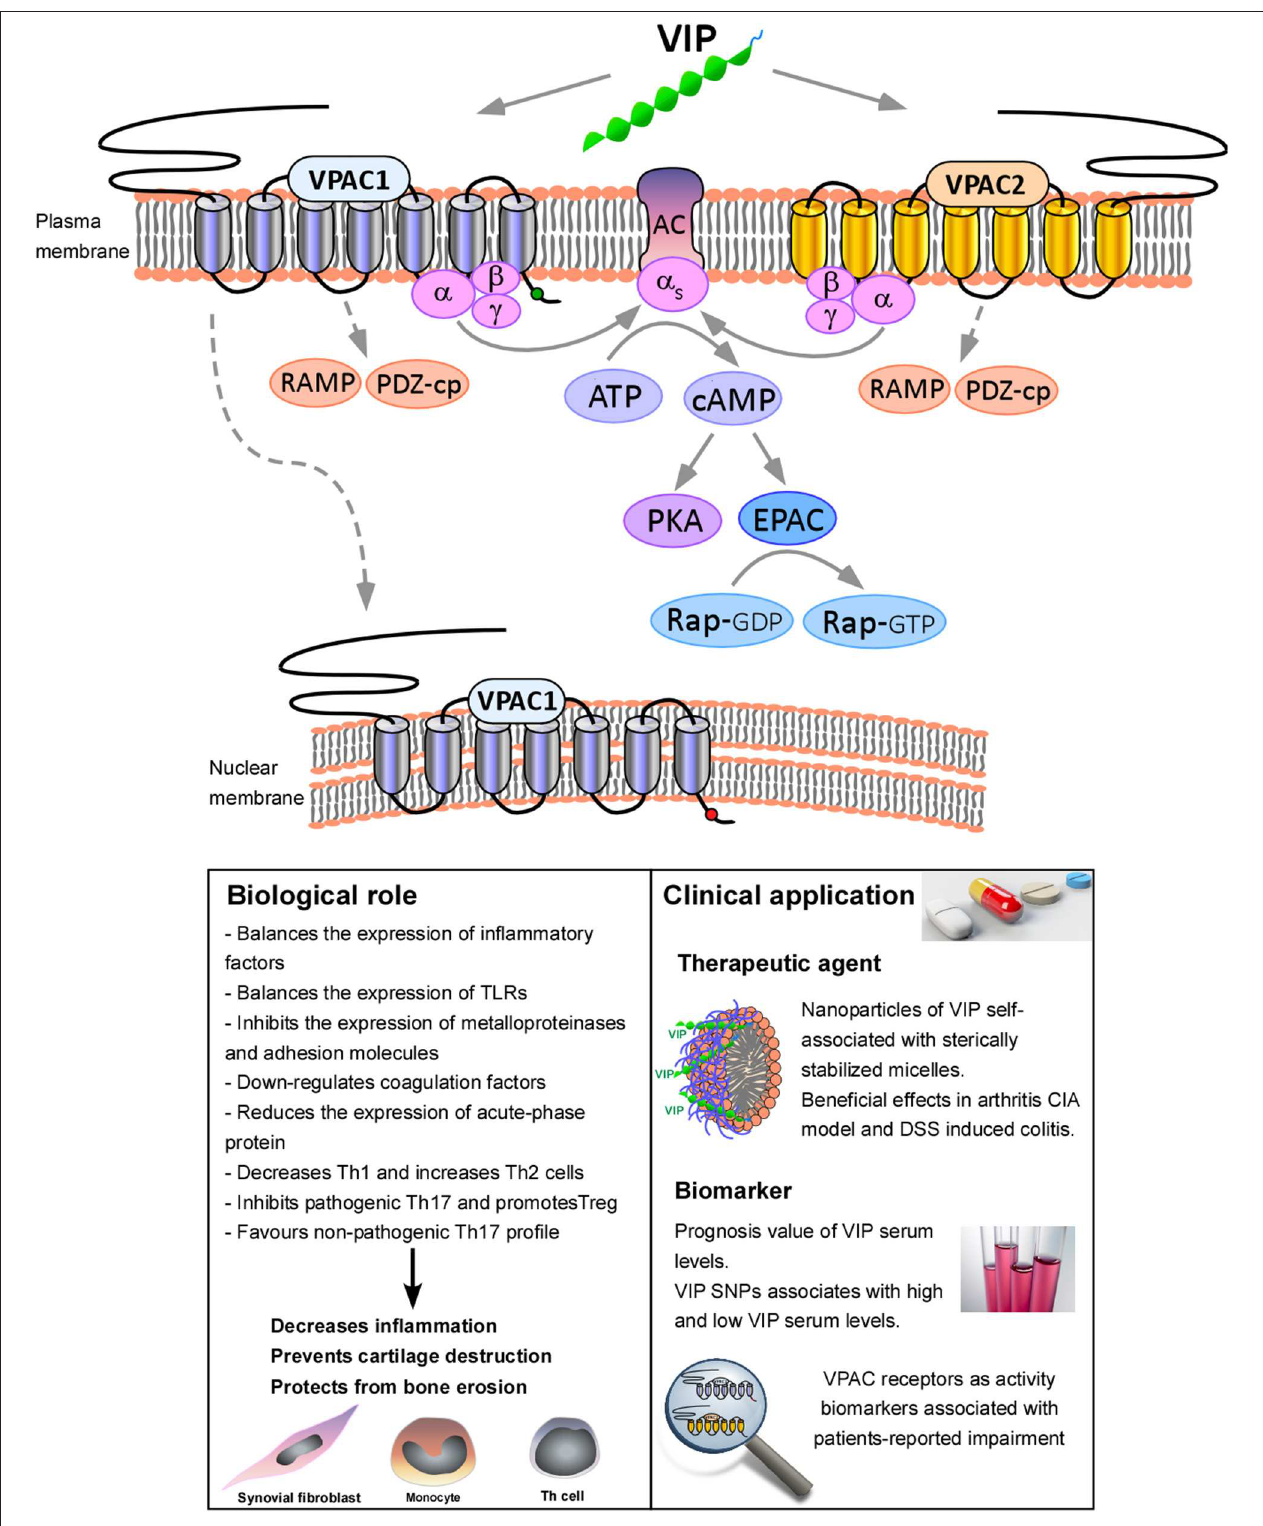
FIGURE 1 | Functional consequences of VPAC receptors signaling. VIP binds both, VPAC1 and VPAC2. VPAC receptors have greater affinity for G α s than G α q, indicating that VPAC receptors preferentially stimulate adenylyl cyclase (AC) activity, increasing cAMP levels and triggering downstream pathways, mainly the canonical PKA pathway and the non-canonical cAMP-activated guanine nucleotide exchange factor (EPAC) pathway. Moreover, these receptors can also interact with accessory